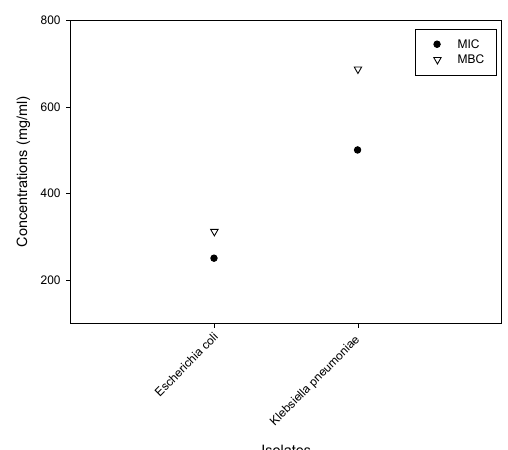
Figure 3: Minimum bactericidal concentration of Honey ( Apis mellifera ) on test